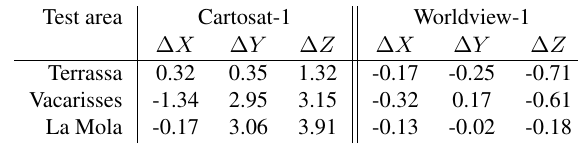
Table 2: 3D shifts between the DEMs and the LIDAR points. Unit: